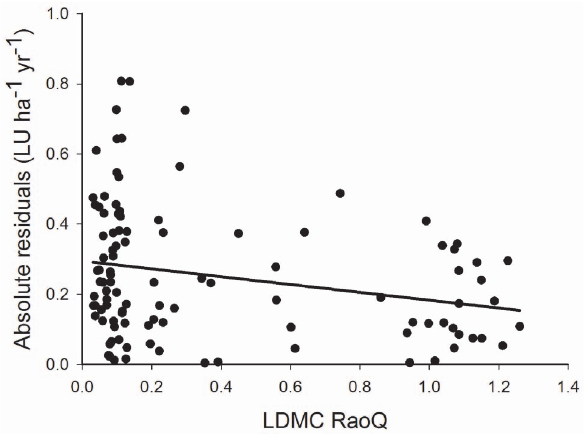
Figure 3. Resilience and functional diversity. The response of the absolute residual after fitting LDMC and rainfall to the Rao’s Q of LDMC. Details of model fit and parameters are in Table 2. Details of the LDMC and rainfall model are given in Table 1.